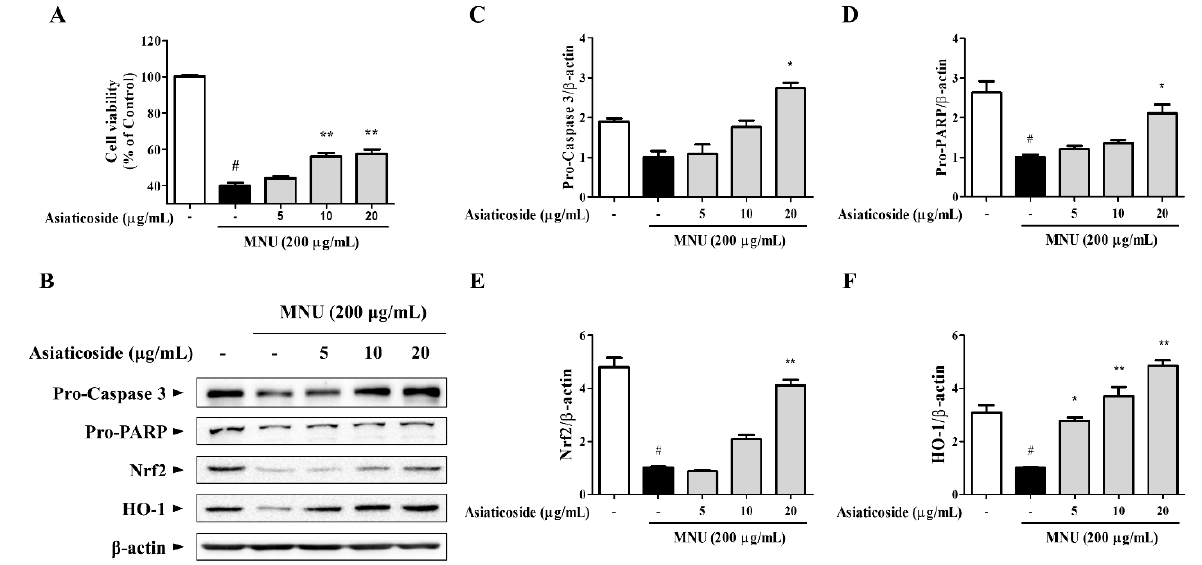
Figure 6. The anti-apoptotic efficacy of CA-HE50 by the activated antioxidant signaling pathway is attributed to asiaticoside. ( A ) Cytoprotective effect of asiaticoside against MNU. ( B ) Western blot analysis for expression of proteins associated with retinal damage with MNU. Asiaticoside efficacy results on: ( C ) pro-caspase-3 protein expression; ( D ) pro-PARP protein expression; ( E ) Nrf2 protein expression; and ( F ) HO-1 protein expression. # p < 0.05 vs. normal control group. * p < 0.05 and ** p < 0.01 vs. MNU-treated group. Abbreviations: MNU, N -methyl- N -nitrosourea; PARP, poly (ADP-ribose) polymerase; Nrf2, nuclear factor erythroid 2; HO-1, heme oxygenase-1.